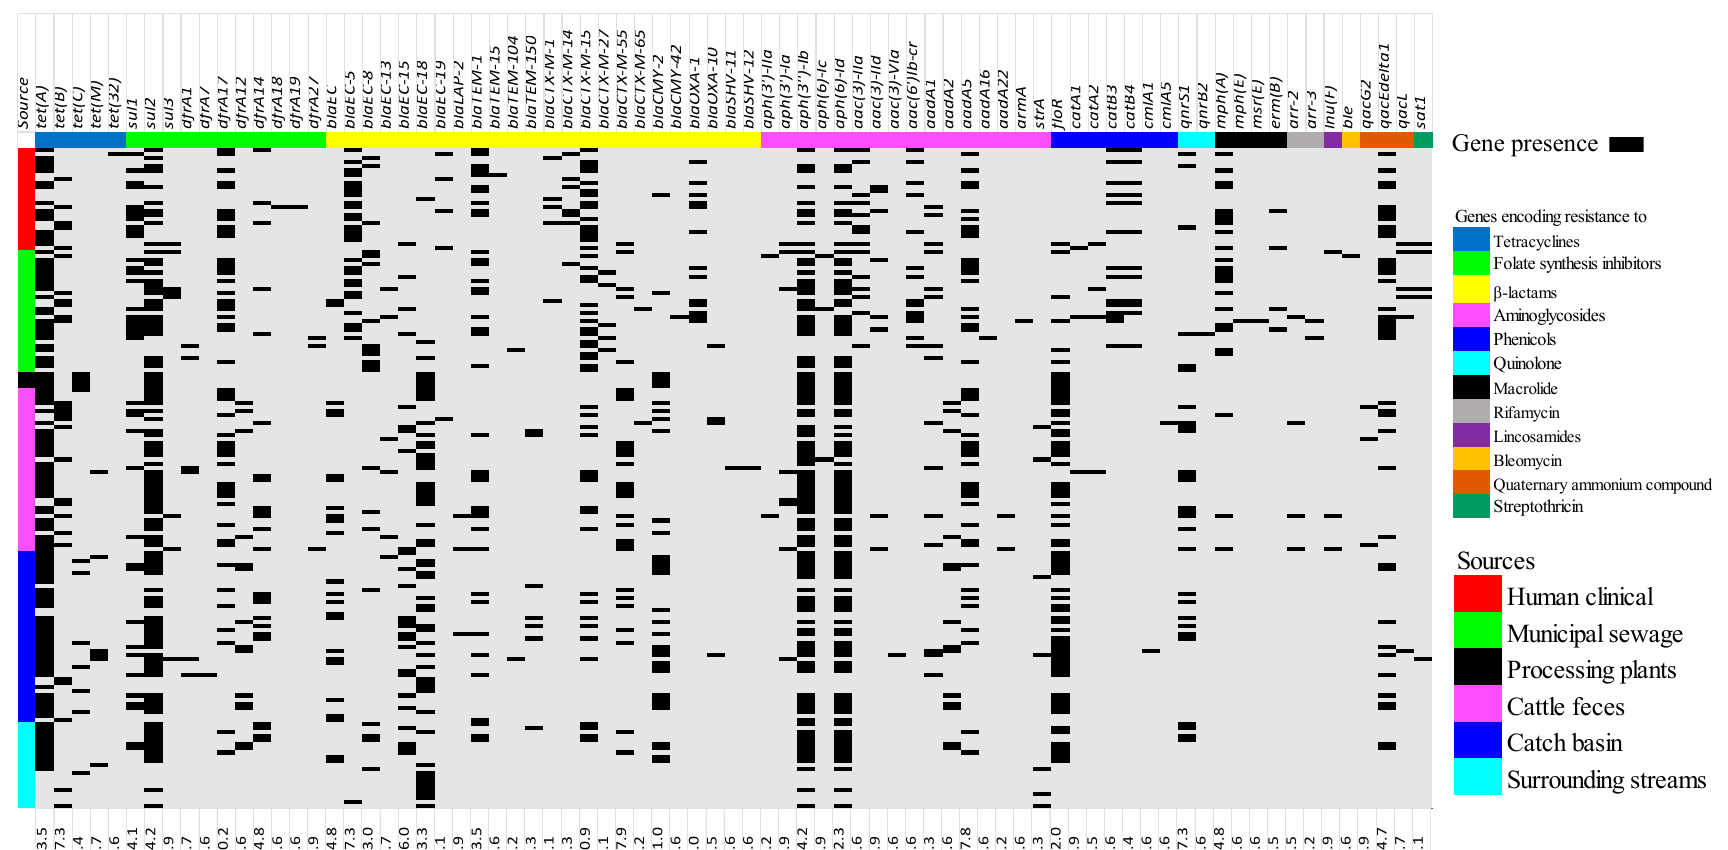
Figure 2. Heat map of resistance genes associated with various classes of antimicrobials as detected by the whole genome sequences of 162 presumptive ESBL-producing E. coli across a One Health continuum: Isolates originated from multiple segments of the One Health continuum including human clinical, municipal sewage, beef processing plant, cattle feces, catch basin, and surrounding streams. aac-(6 ′ )-Ib-cr classified under aminoglycoside also encodes quinolone resistance. The overall prevalence of each determinant is displayed as a numeric percentage at the bottom of each determinant.